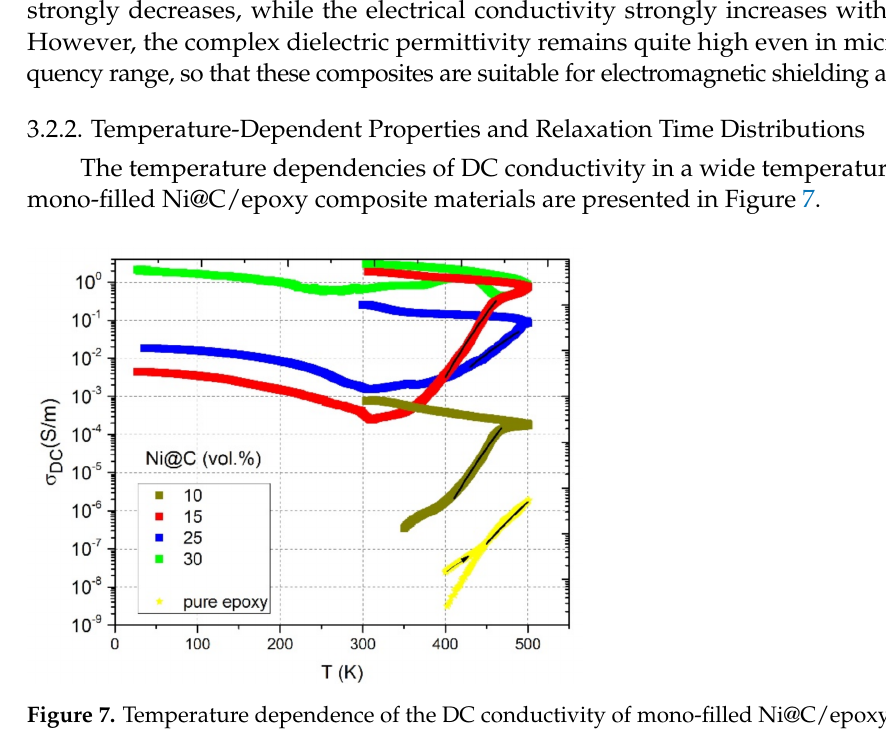
Figure 7. Temperature dependence of the DC conductivity of mono-filled Ni@C/epoxy composites with different Ni@C content. Solid lines at high temperatures correspond to approximations according to Equation